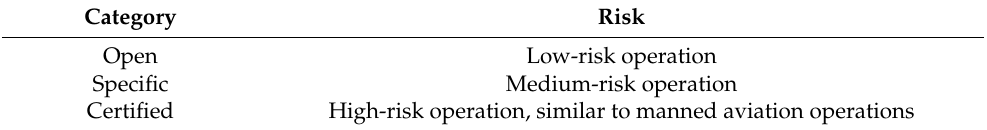
Table 1. Categorization of drone operations in the new European regulation.